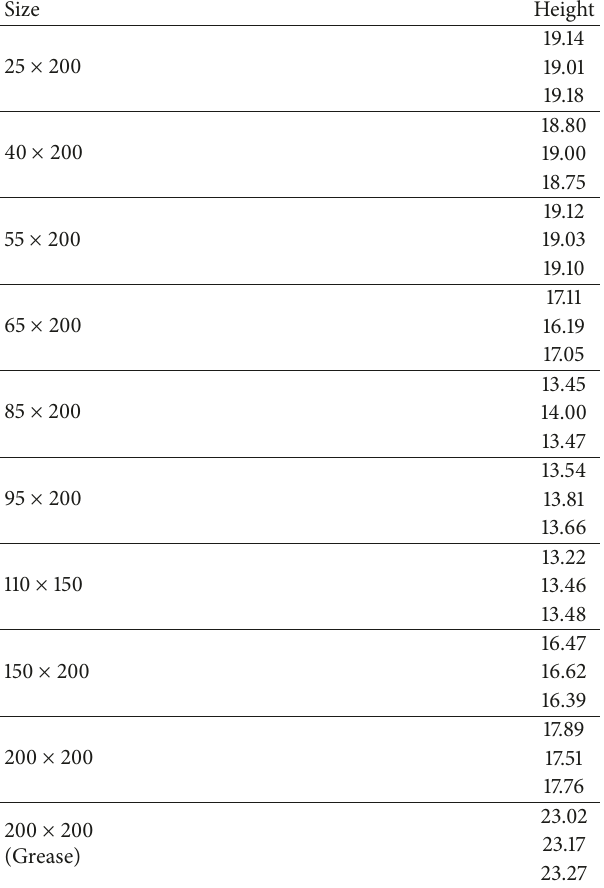
Table 4: Dome height from the LDH test (unit: mm).